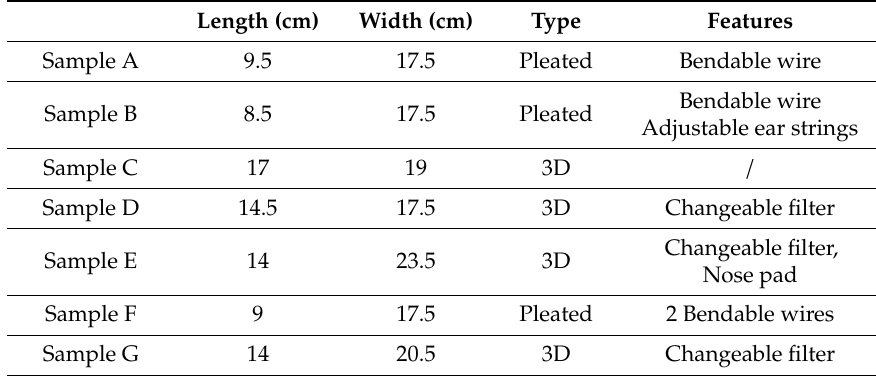
Figure 6. Front and side views of ( a ) Sample A, ( b ) Sample B, ( c ) Sample C, ( d ) Sample D, ( e ) Sample E ( f ) Sample F, and ( g ) Sample G. Table 4. Size and design characteristics of masks.